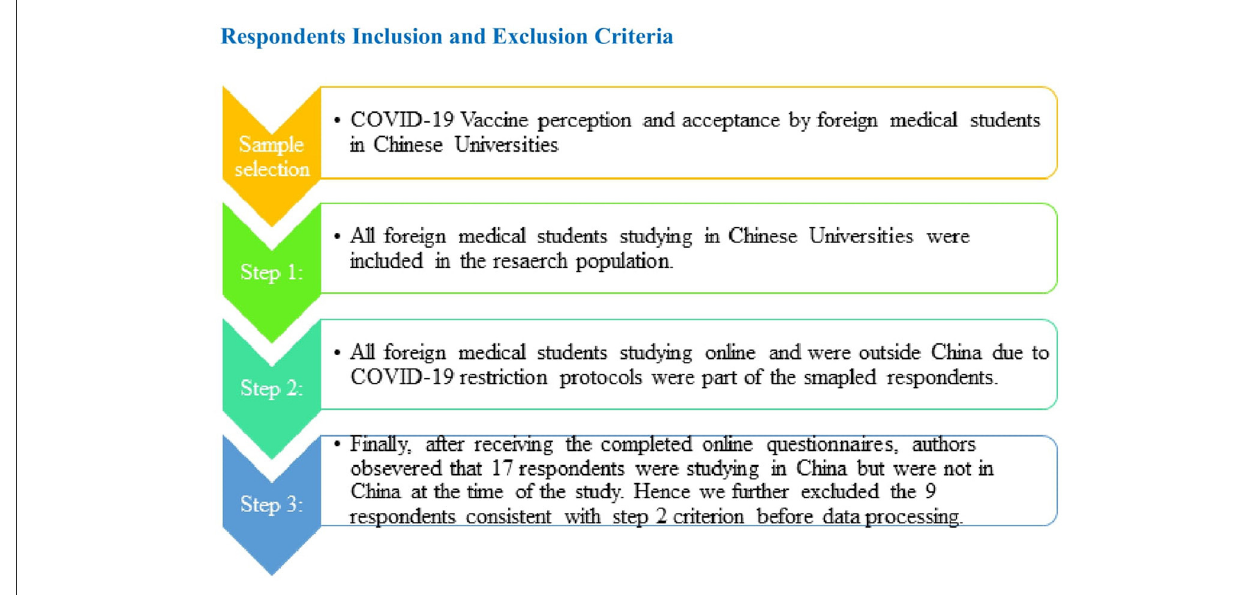
FIGURE1 Respondents’ inclusion and exclusion